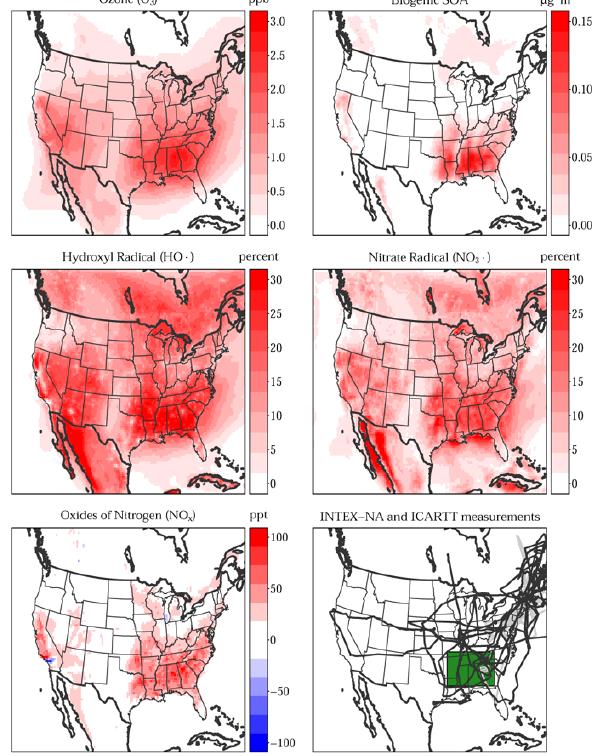
Fig. 3. Changes in the surface concentrations of selected model species between the base and IS simulations averaged over the en- tire modeling period. DC-8 and WP-3D flight tracks are shown in dark grey and light grey, respectively. The green box indicates the southeastern United States subdomain described in the Results sec-